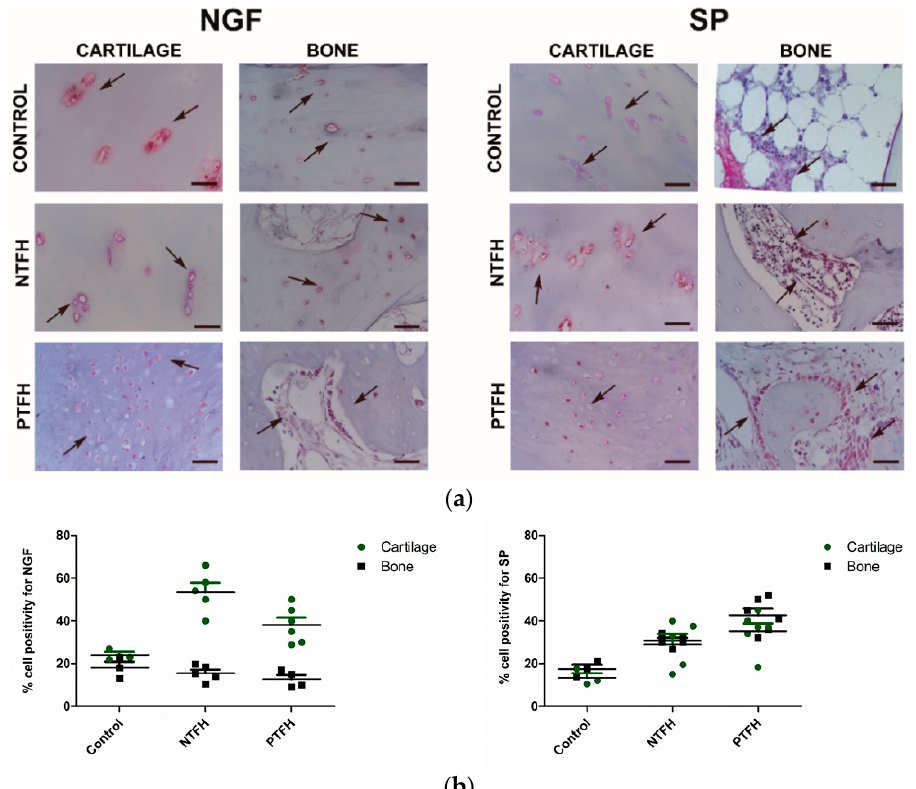
Figure 5. ( a ) Immunostaining for NGF and SP in osteochondral tissues from control, NTFH and PTFH groups. Scale bar: 50 μ m. Black arrows: positive areas for the selected markers. ( b ) Graphical representation of quantitative measurements for NGF and SP in control, NTFH and PTFH groups. Data are expressed in a scatter plot graph with mean ± standard deviation (SD).